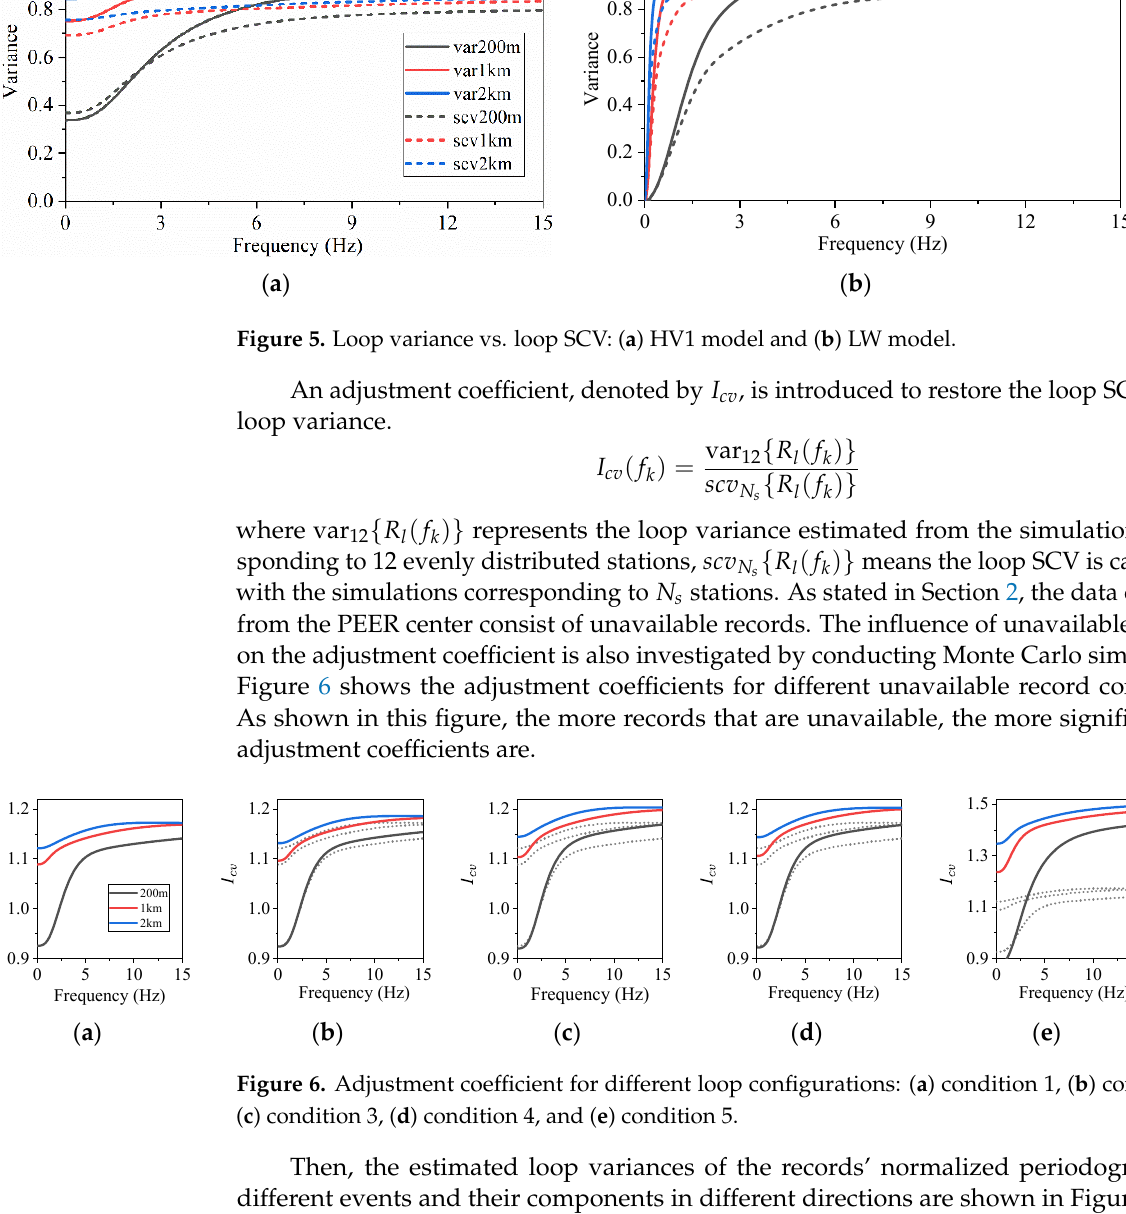
( c ) Figure 7. Loop variance of in different loops: ( a ) inner loop, ( b ) middle loop, and ( c ) outer loop. In each subgraph of Figure 7, the NPLVs show features similar to that of the FAS amplitude variation reported by Liao and Zerva [14]. As shown in this figure, the NPLVs increase with frequency and reach a relatively steady stage at 6.25 Hz, which is 1/16 of the sampling frequency. In Figure 7b, the average NPLV beyond 12.5 Hz continues to increase to an extremely high value, which can be attributed to the dividing of the small value when calculating the SCV of the normalized periodograms. The energy in the PSD of the five events beyond 12.5 Hz is small and has a low signal-to-noise ratio. The NPLVs for different loops in different events exhibit similar trends with the increase in frequency, indicating that the NPLV is a suitable index for describing spectral amplitude variation. The average of the inter-event mean value of the NPLVs between 6.75 and 12.25 Hz for each loop, denoted by σ 2 , R I , σ 2 , R M , and σ 2 , R O , respectively, are listed in Table 3.